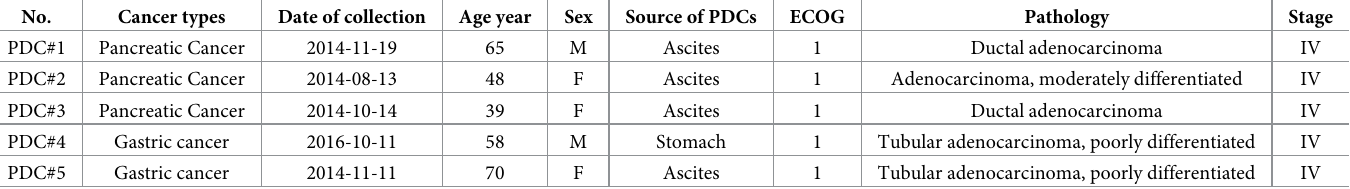
Table 1. Baseline clinical features of patient-derived cancer cells.